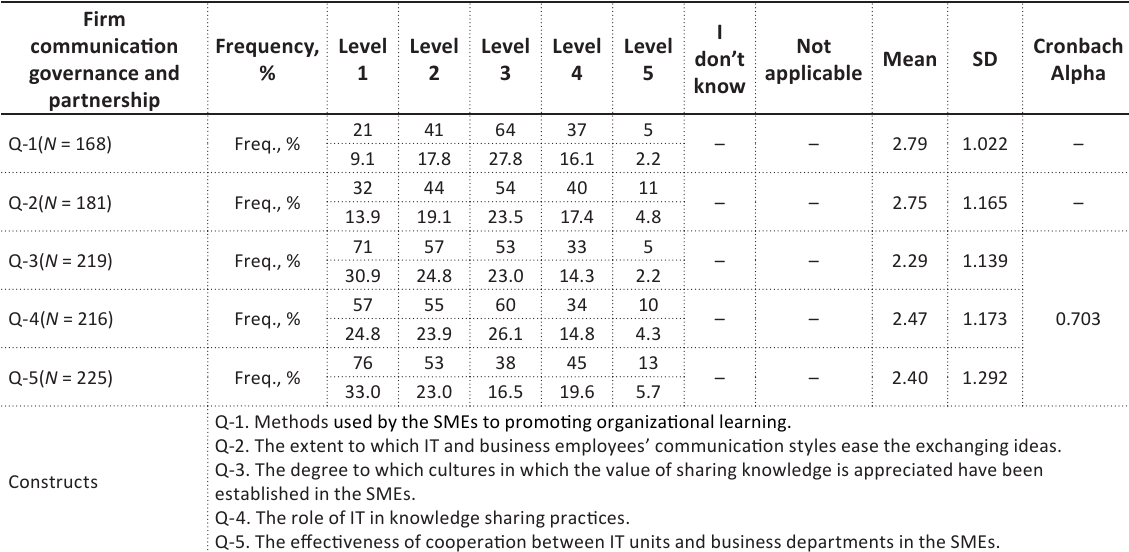
Table 1. The levels of SME’s IT integration to promote knowledge sharing practices